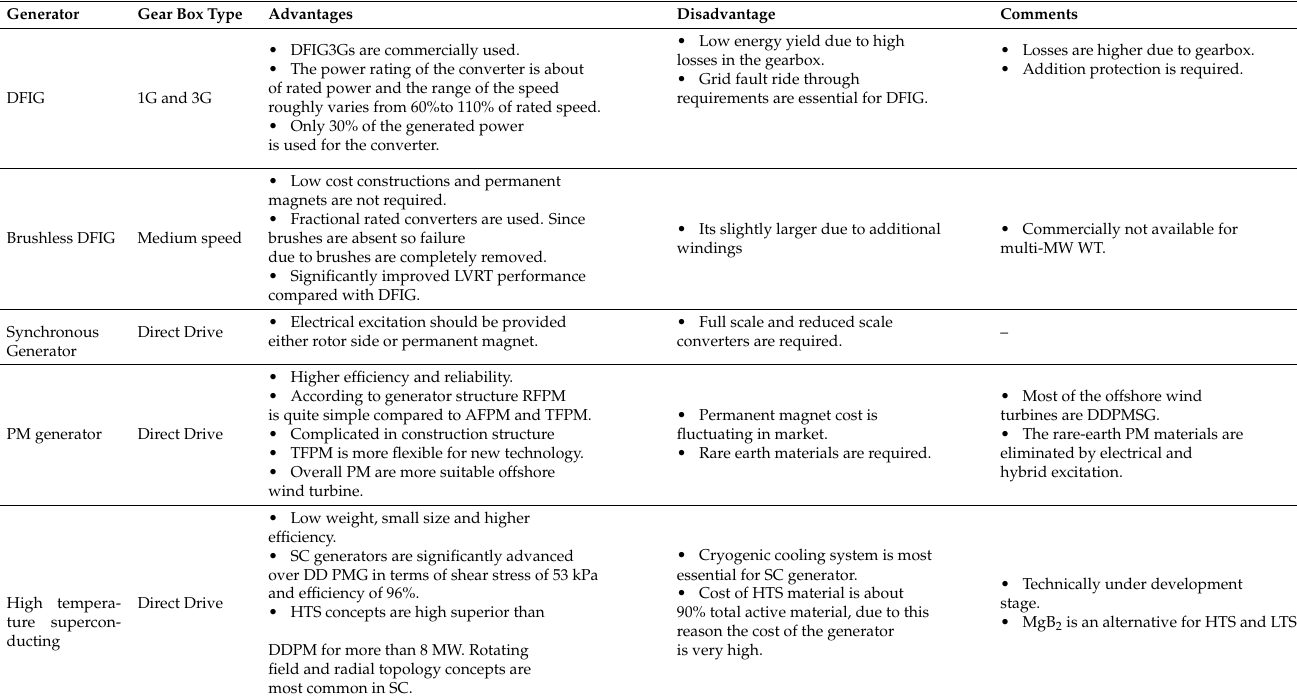
Table 1. Comparison of different generator